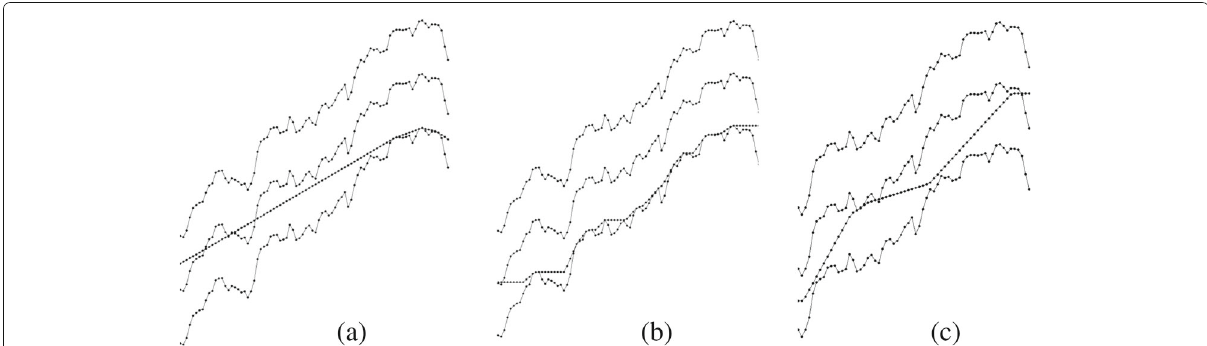
Fig.11 a K = 60, b K = 2 without C M ( n , i ) ,and c K = 2 with C M ( n , i ) .Weights areset at a (0.01,0.01,0), b (0.01,0.01,0), and c (0.01,0.01, 1),respectively